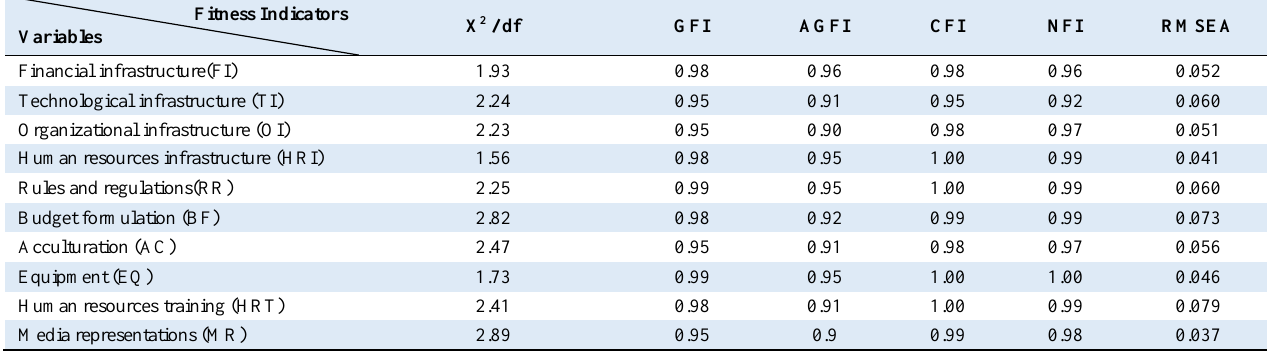
Table 3. Fitting indicators of research variables